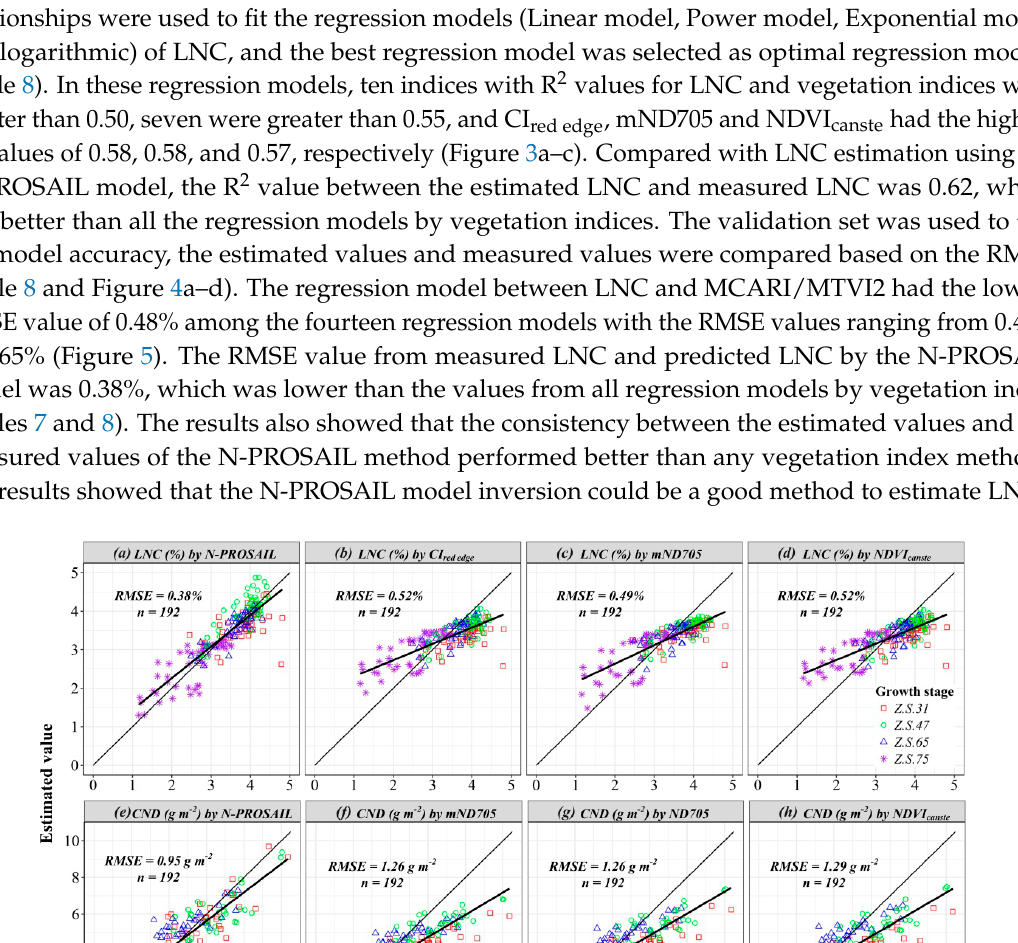
Table 8. Relationships between LNC and vegetation indices ( n = 384).